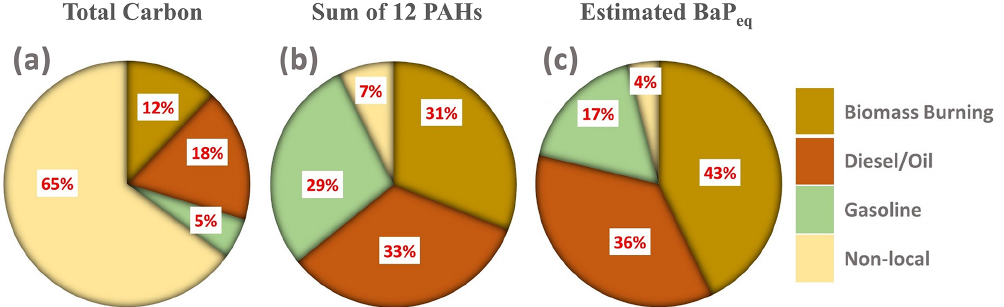
Figure 3. Fractional contributions of PMF-resolved sources to mean modeled concentrations of (a) TC, (b) the sum of 12 PAHs included in the PMF analysis, and (c) estimated BaP eq